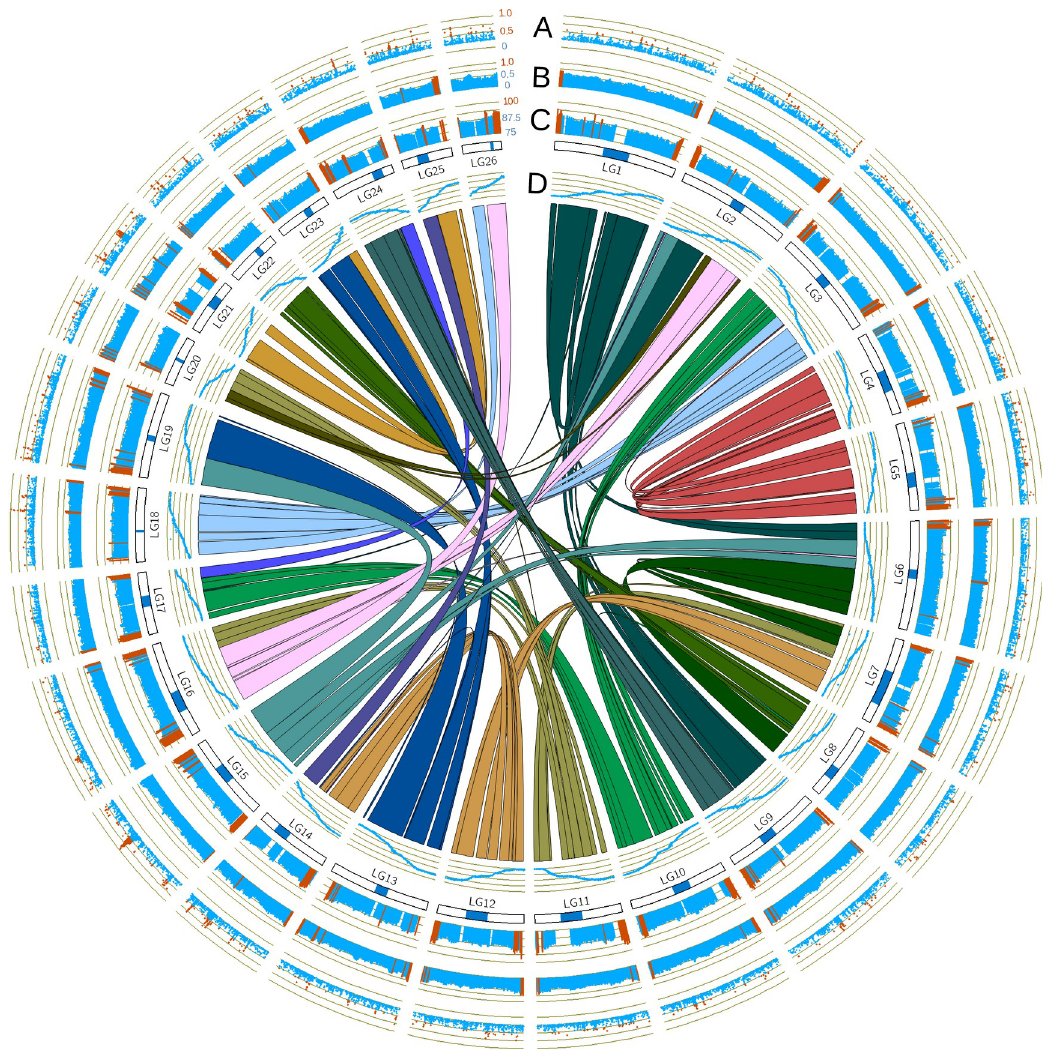
Fig 1. Circos plot of pink salmon genome assembly. Positions are all based on the odd-year genome assembly. Chromosomes/ linkage groups are noted with blue boxes representing the centromere identified in Tarpey et al. (2017) [64]. Links between chromosomes are homeologous regions identified using SyMap. A) Fst values between all odd-year and even-year salmon greater than 0.25. Values greater than 0.5 are highlighted red. B) The fraction of repetitive DNA as identified by NCBI (odd-year). Values greater than 0.65 are highlighted red. C) The percent identity between homeologous regions identified by SyMap (scale 75–100%). Values greater than 90% are highlighted red. D) A Marey map with markers from the genetic map (y-axis, 0–1, with 1 being the marker with the greatest cM value) placed onto the genome (x-axis,